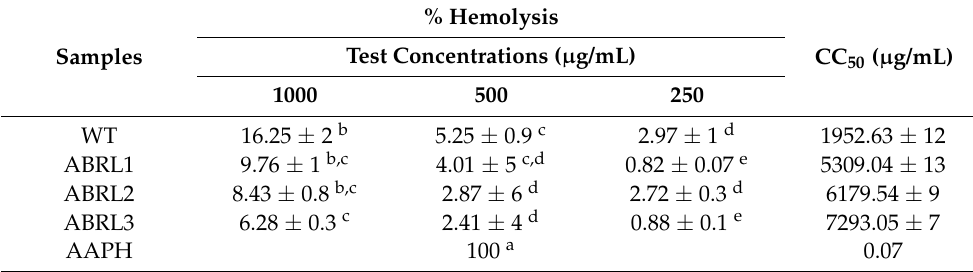
Table 3. Hemolytic activity of Ajuga bracteosa